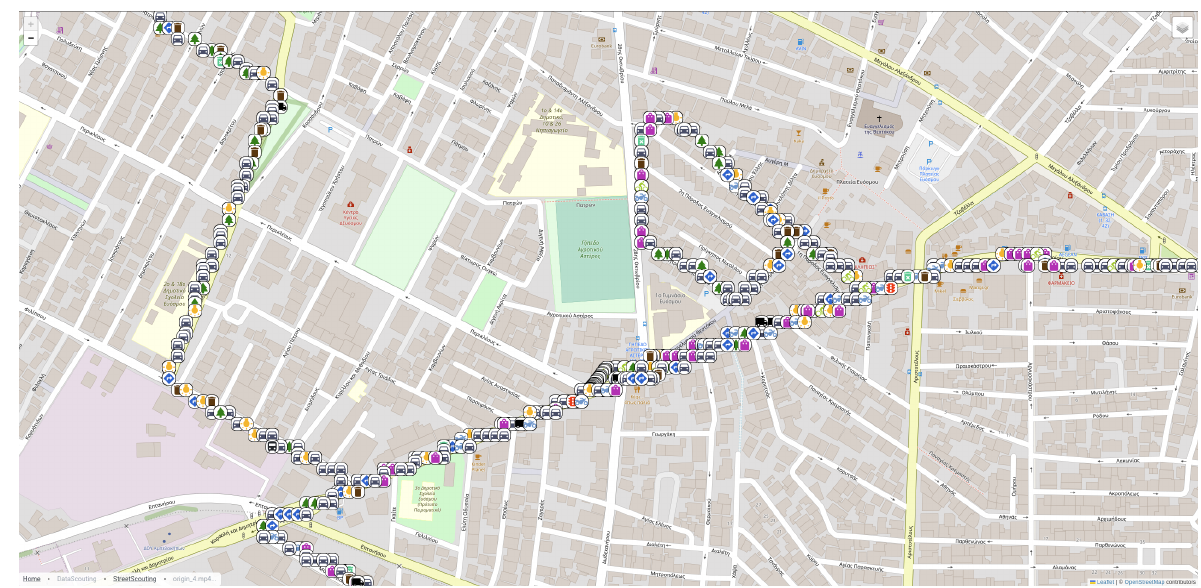
Figure 9. Map visualization of the detected features from a sample video in the city of